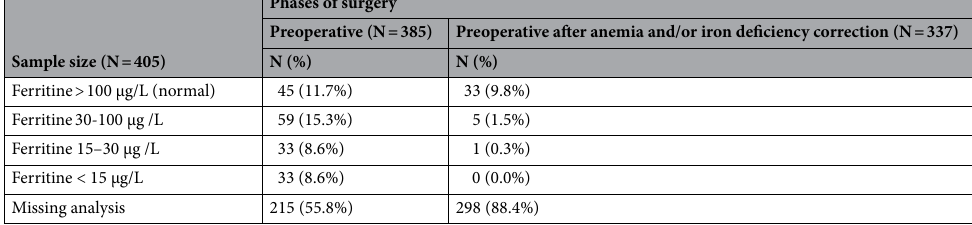
Sample size (N = 405)